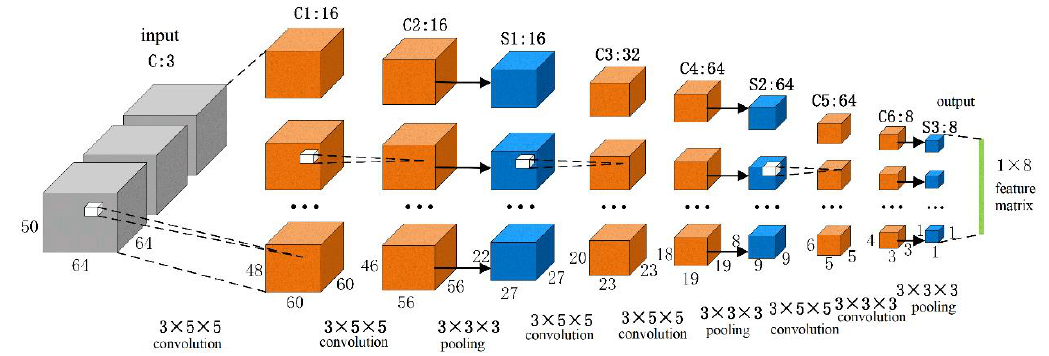
Figure 3. Structure diagram of 3D CNN with multiple channels.